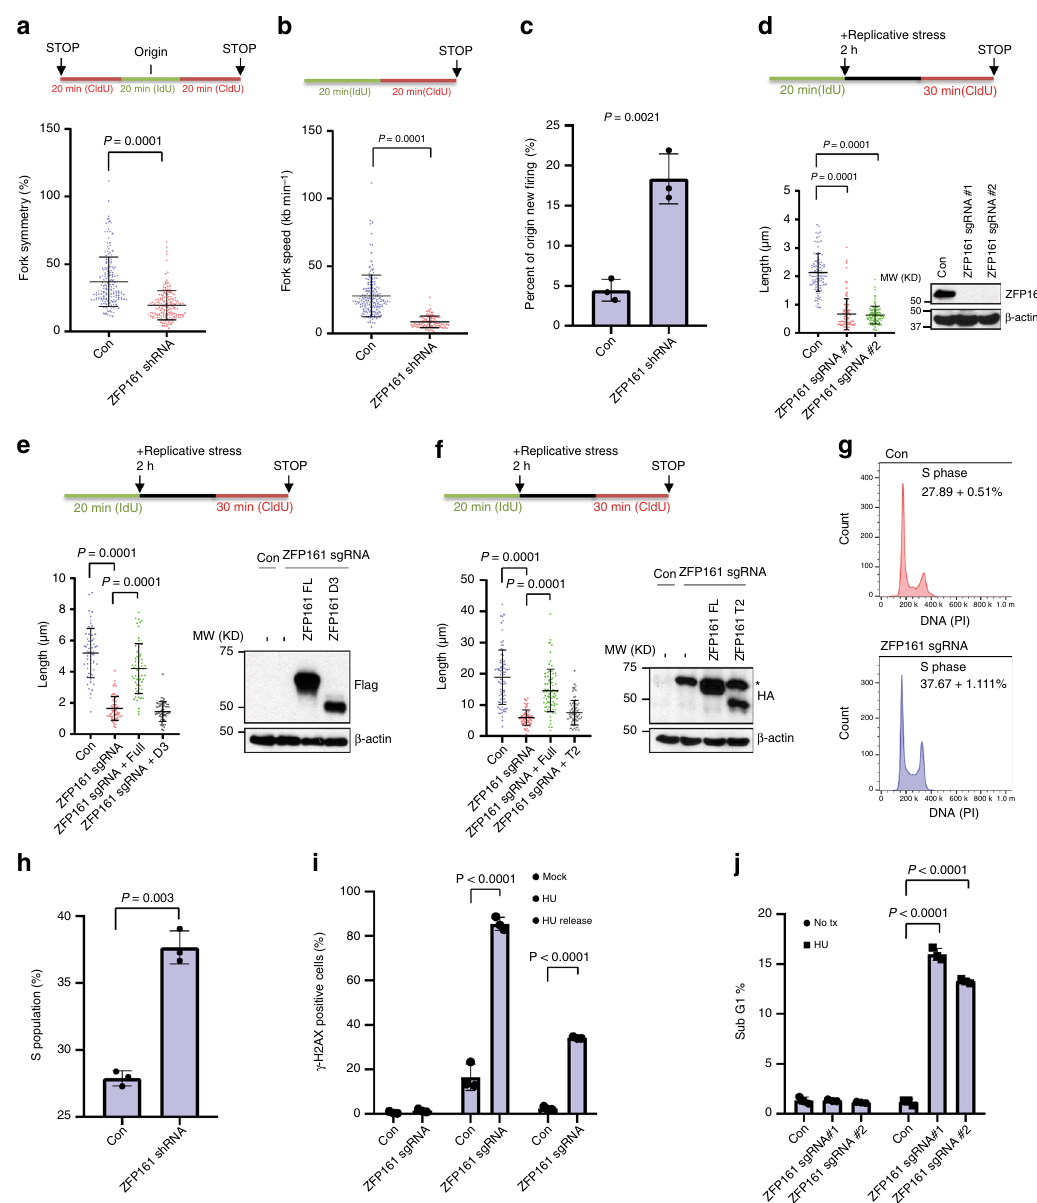
Fig. 5 ZFP161 promotes stalled replication fork restart a , b HCT116 cells were labeled with IdU and CldU for indicated time. Fork symmetry a and fork speed b were determined by measuring the length of CIdU (red) track. c The percentage of new origins (red only fi bers) was quanti fi ed. n = 313 fi bers for WT and n = 285 fi bers for ZFP161 knockout. d – f Cells were labeled with IdU for 20 min and then cells were incubated with 4 mM HU for 2 h. After incubation, cells were labeled with CldU for 30 min. ZFP161 KO cells ( d ) or KO cells reconstituted with full length ZFP161 and the D3 mutant ( e ), or the T2 mutant ( f ) were used. DNA fi bers were stretched on a microscope slide, stained with IdU and CldU antibodies, imaged, and the lengths of fi ber tracks measured. The graphs represent mean ± S.D., two-tailed, unpaired t -test. g , h Cell cycle distribution was determined by fl ow cytometry in cells either lacking or expressing ZFP161 ( g ). S phase populations were analyzed by Modi fi t ( h ). i , j HCT116 cells were treated with 2 mM HU for 24 h and released. Cells were collected and γ - H2AX ( i ) and sub G1 population (an indicator of cell death) ( j ) were determined by fl ow cytometry. *: unspeci fi c bands The graphs represent mean ± S.D., two-tailed, paired t -test; n = 3 independent experiments. Source data are provided as a Source Data fi In summary, our study clari fi es ZFP161 as a regulator of ATR signaling. ZFP161 functions as an adaptor protein for connecting ssDNA-RPA and ATRIP/ATR complex, which activates ATR signaling pathway under replication stress and maintains geno- mic stability (Fig. 6m).